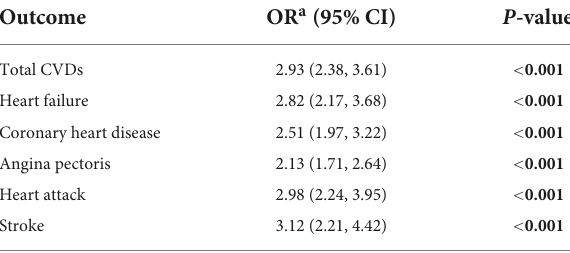
TABLE 2 Associations between MMA (ln nmol/L) and CVDs by univariable logistic regression model. Outcome OR a (95% CI) P -value Total